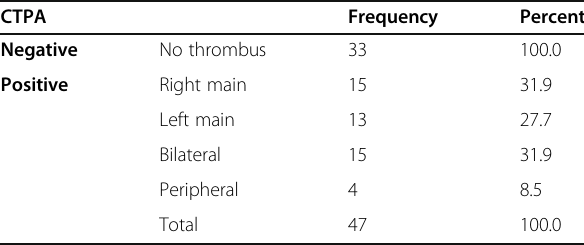
Table 1 Distribution of site of thrombus in pulmonary artery among positive cases by CTPA CTPA